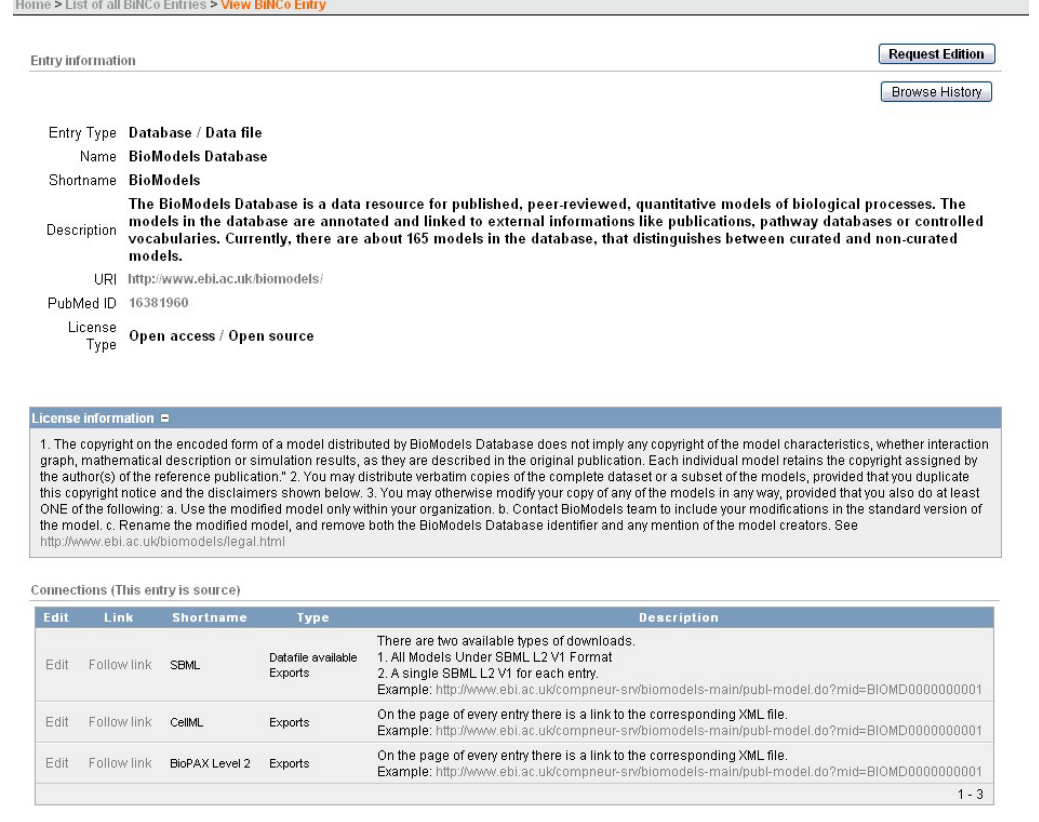
Figure 4: View of an entry of BiNCo-wiki. This page displays all information available for an entry, here the information for the entry